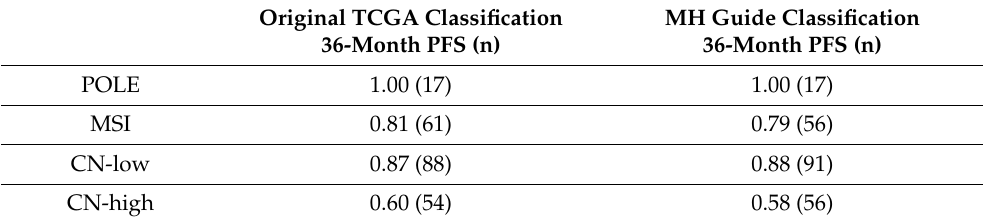
Figure 2. Kaplan–Meier survival curves for progression-free survival (PFS; ( A , B )) and overall survival (OS; ( C , D )) of the EC cohort according to TCGA classification ( A , C ) and MH Guide algorithm ( B , D ). Due to lack of clinical data, the number of patients in the respective groups differed (PFS: n = 220, OS: n = 232). Log-rank p-values are given as inserts. Table 2. The 36-month PFS of subtypes by original TCGA classification and based on the MH Guide algorithm.